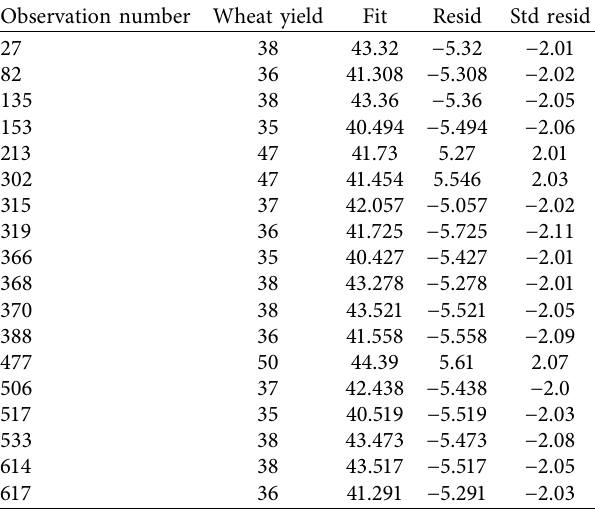
Table 5: Residual analysis for the regression based on full data. Observation number Wheat yield